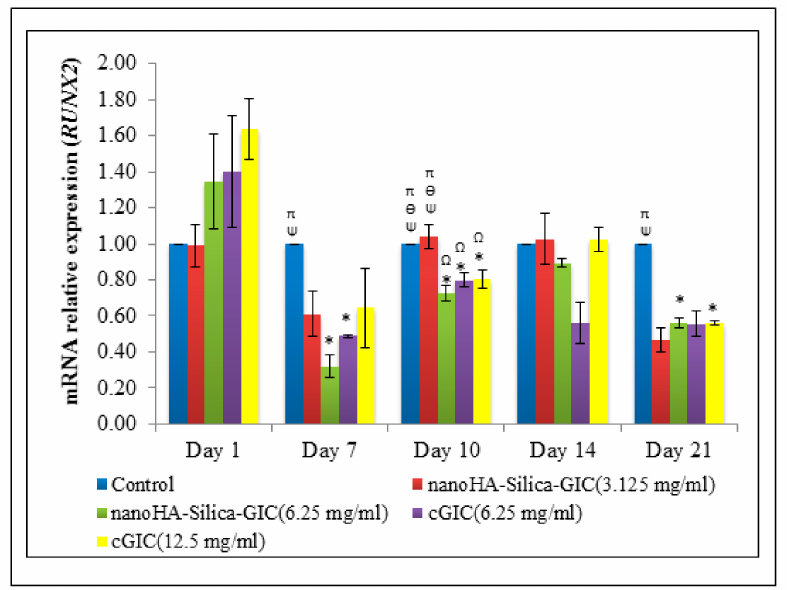
Figure 4. Expression of odontogenic gene marker, Runt-related transcription factor 2 ( RUNX2 ) based on real time reverse transcription polymerase chain reaction (rRT–PCR) in dental pulp stem cells (DPSCs). The data are presented as the mean ± standard error of mean (SEM). * indicates a significant di ff erence compared to C (control). Ω indicates a significant di ff erence compared